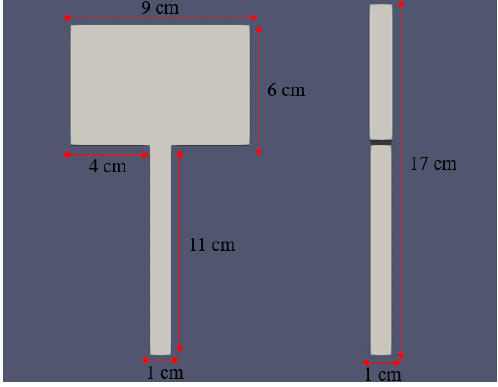
Figure 1. Schematics showing the dimensions of the beam. Table 1. Characteristics of fluid and solid in numerical and experiment methods.